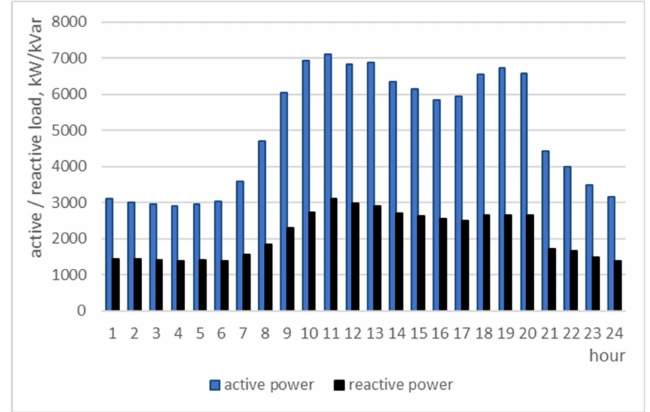
Figure 13. The active and reactive load profiles of the IEEE 33-bus test system—hourly